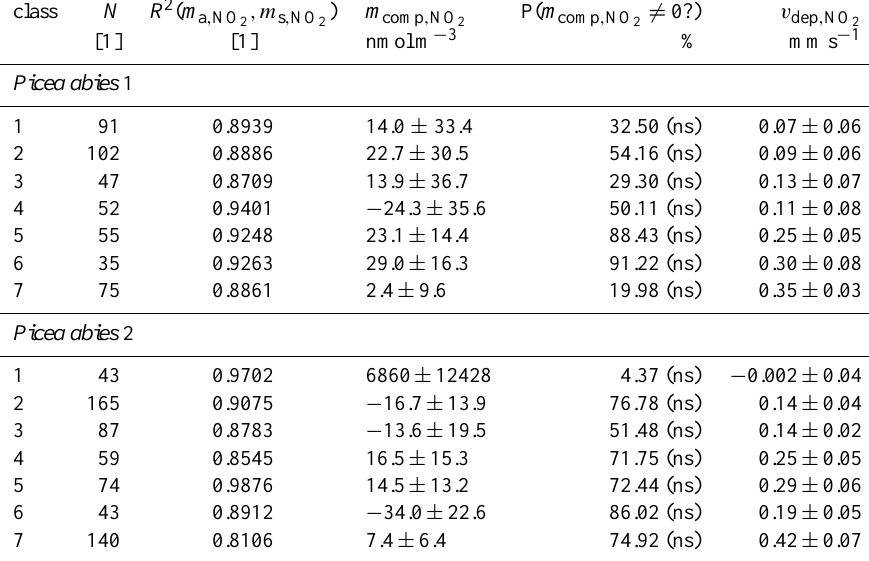
Table 4. Parameters of NO 2 field measurements of bi-variate weighted linear least-squares fitting regression analysis (standard error of m s , NO and m a , NO considered). Data were separated for leaf conductance g H 2 2 = (m − m 1m NO a , NO 2 s , NO 2 ) were applied. 2